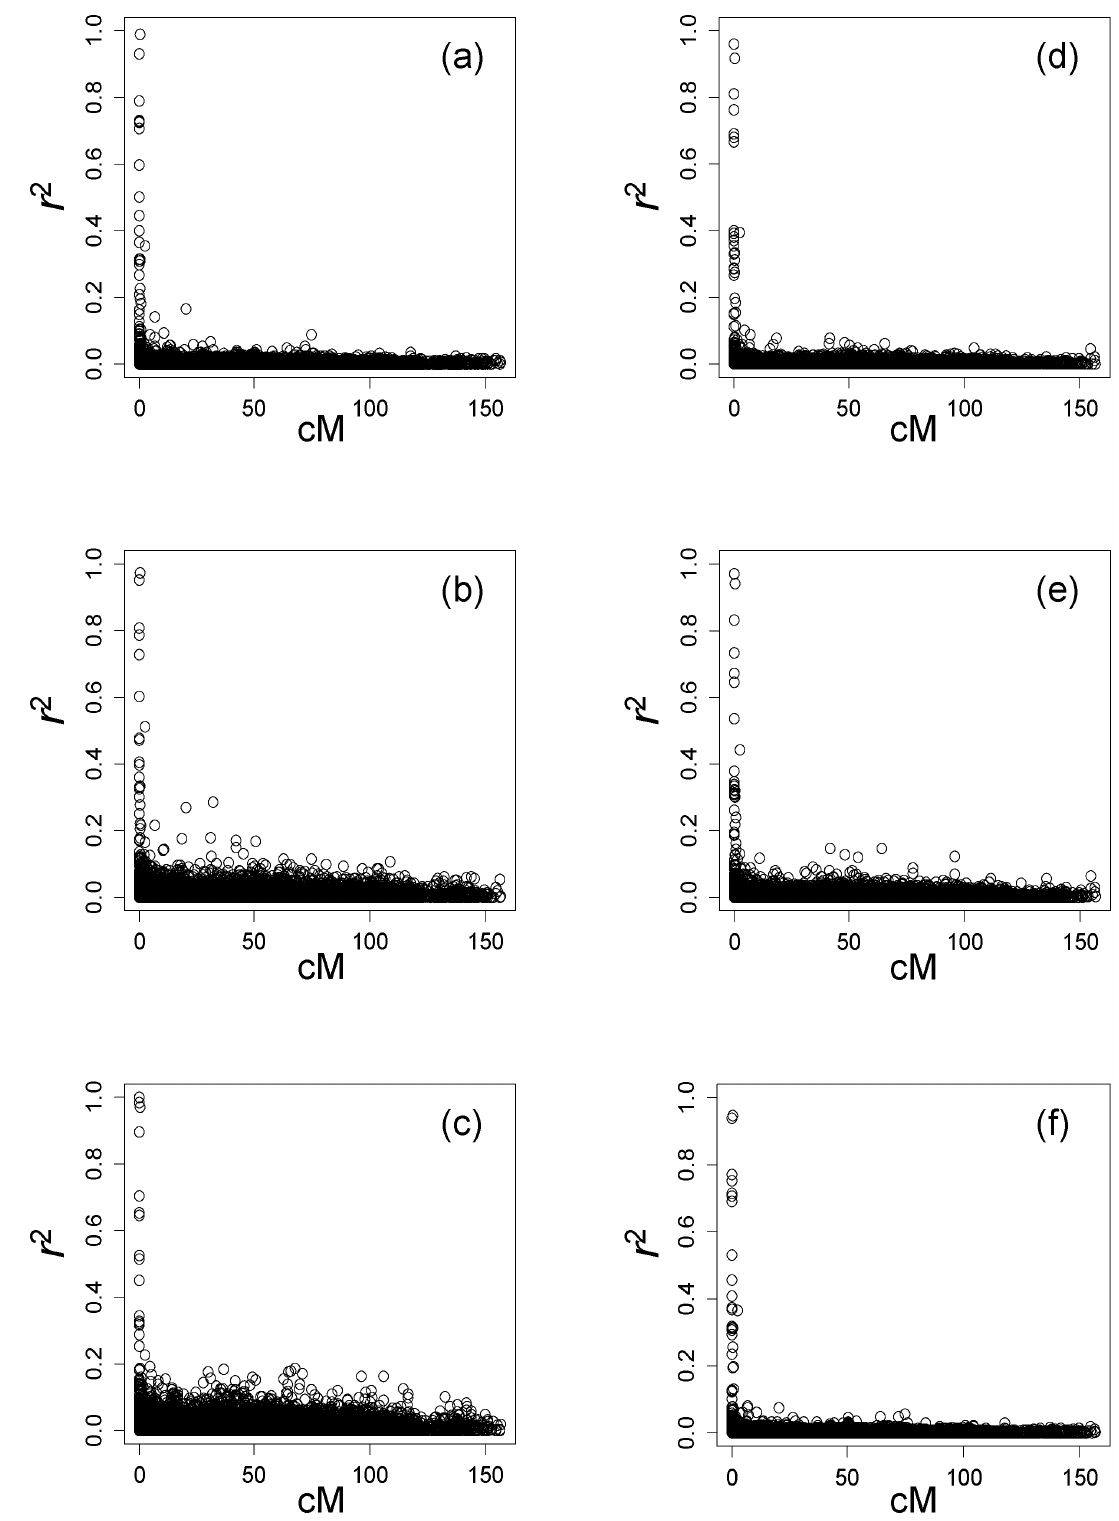
Figure 2. Linkage disequilibrium r 2 , versus map distance in cM, for the C.japonica plus trees. (a) core collection (n=456), (b) core collection (Pacific Ocean side (Q . 0.8, n=116)), (c) core collection (Japan Sea side (Q , 0.2, n=80)), (d) plus trees in Kanto Breeding Region (n=367), (e) plus trees in Kanto Breeding Region (Pacific Ocean side (Q . 0.8, n=195),all samples (core collection and plus trees in Kanto Breeding Region (n=731)).